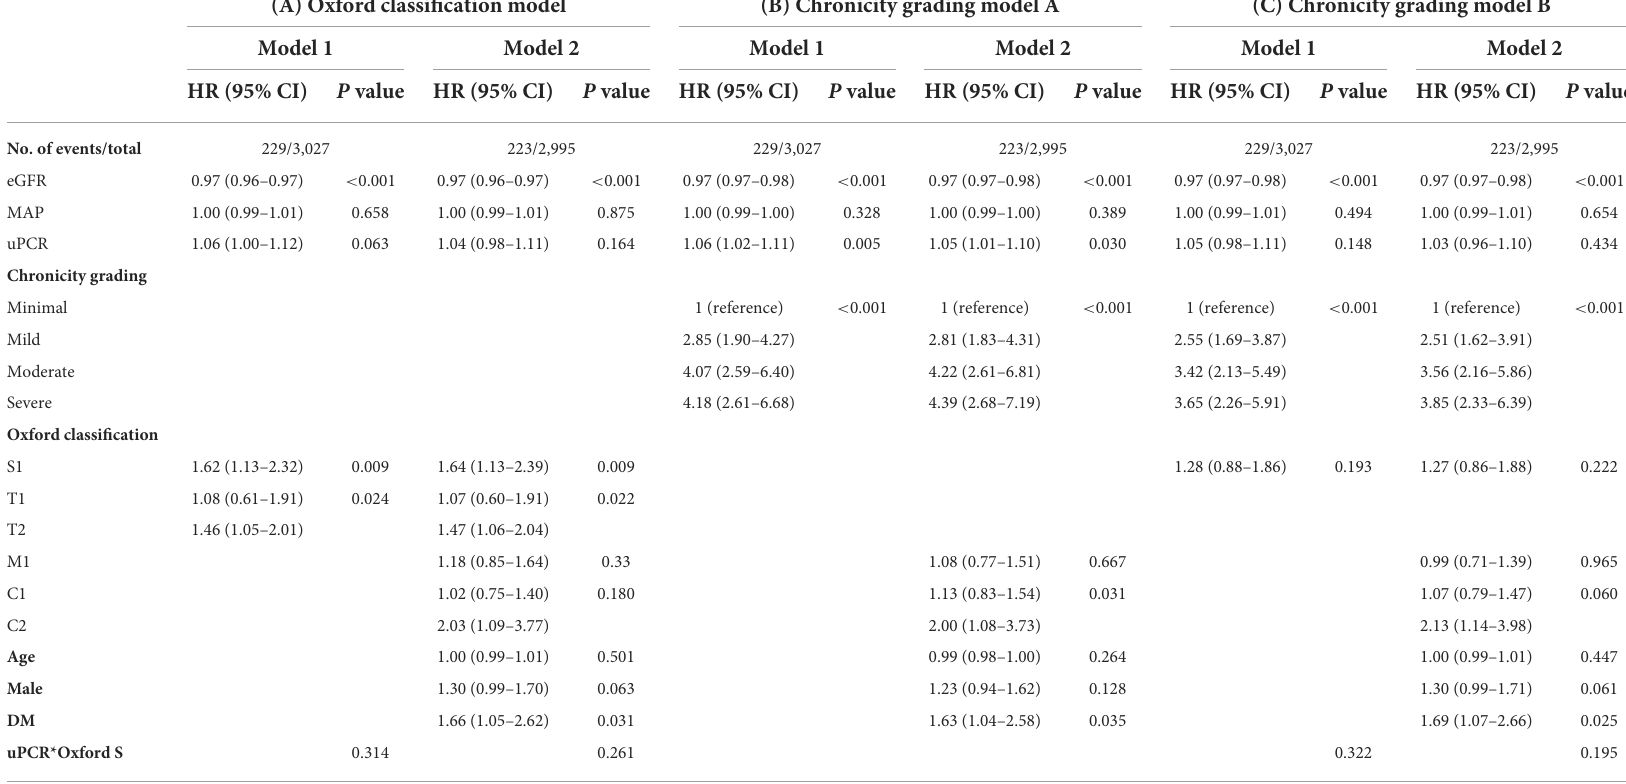
TABLE 6 Association of chronicity grading and oxford classification with ESRD